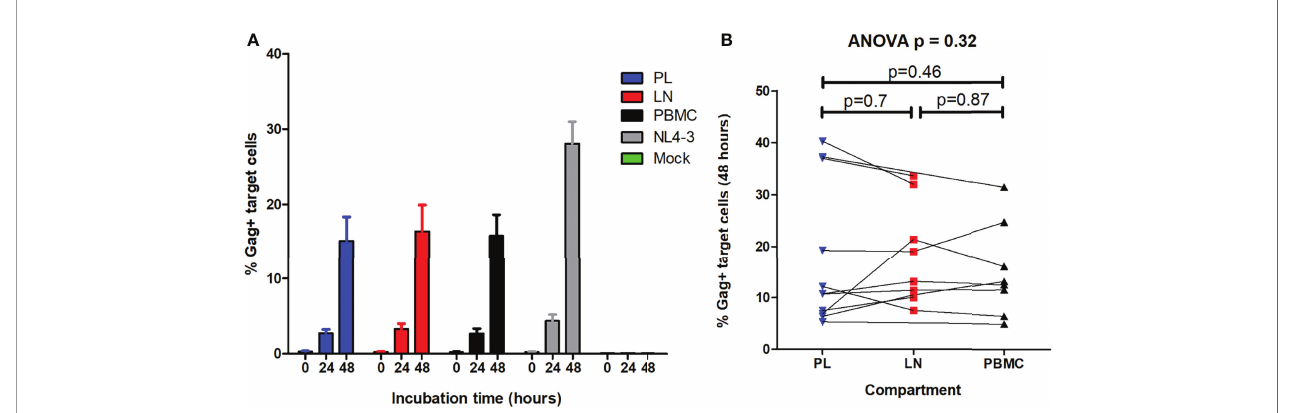
FIGURE 4 | Cell-to-cell spread ability of viruses encoding gag-protease from pre-therapy plasma and the reservoir. HIV cell-to-cell spread of the recombinant viruses encoding gag-protease from the lymph node (LN) and peripheral blood mononuclear cell (PBMC) reservoirs, as well as from the pre-therapy plasma (PL), was measured. Cell-to-cell spread was measured by intracellular Gag staining in target cells, pre-stained with CellTrace ™ far red, after incubation with HIV-infected donor cells (titrated to 5% infection) that were stained with eFlour450. (A) The percentage infected target cells at 0, 24 and 48 hours is shown for the viruses derived from the different compartments, as well as for the positive (NL4-3) and negative (mock) controls. (B) The percentage infected target cells at 48 hours was the measure of cell-cell spread ability. The overall repeated measures ANOVA p value is shown as well as the paired T test p values from two-way comparisons of viruses from the different